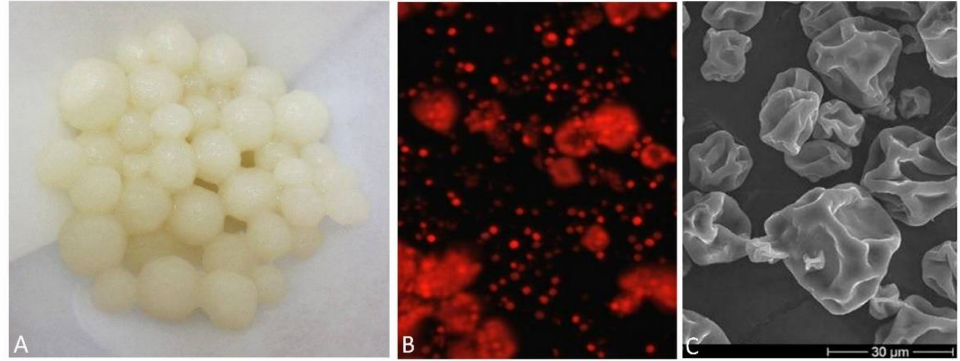
Figure 2. A. niger pellets after washing in distilled water ( A ), dry culture of the algae Chlorella sp. under a fluorescence microscope ( B ), record of a dry culture of the algae Chlorella sp. from a scanning electron microscope ( C ).